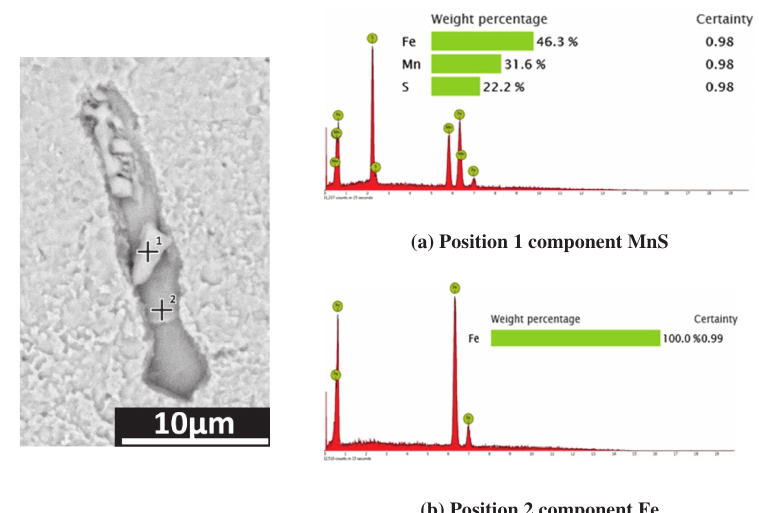
Figure 11: Composition analysis of point 2 at 35 s of